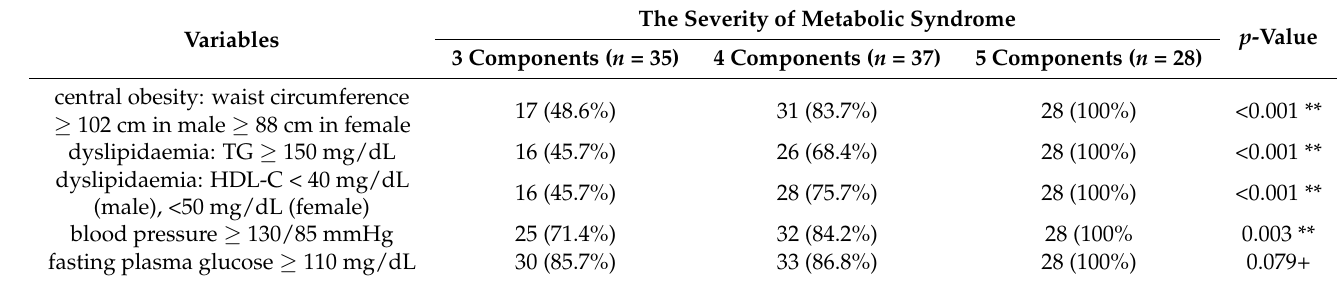
Table 4. Correlation of components of metabolic syndrome with